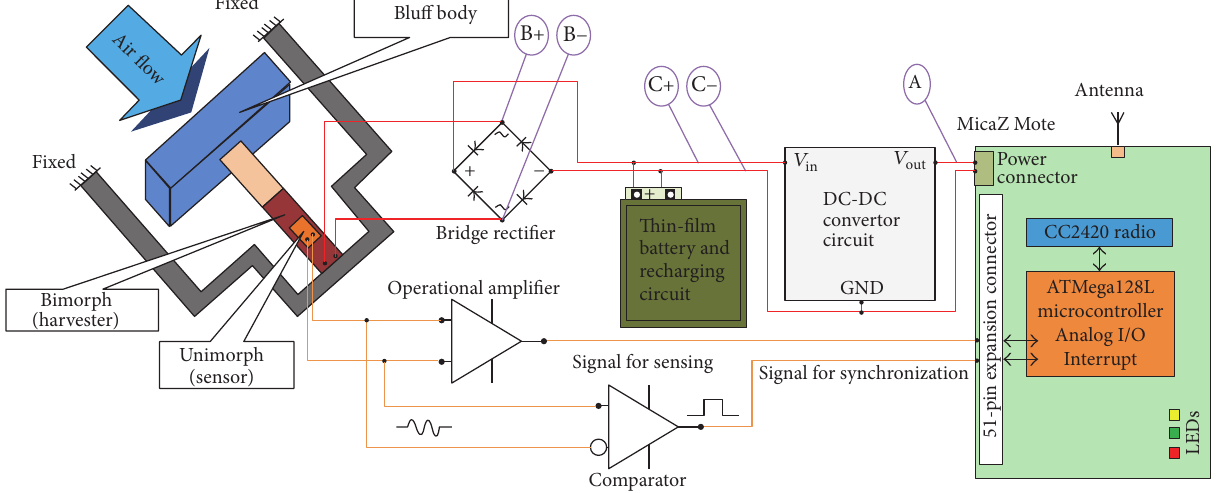
Figure 6: Schematic of Trinity indoor sensing system